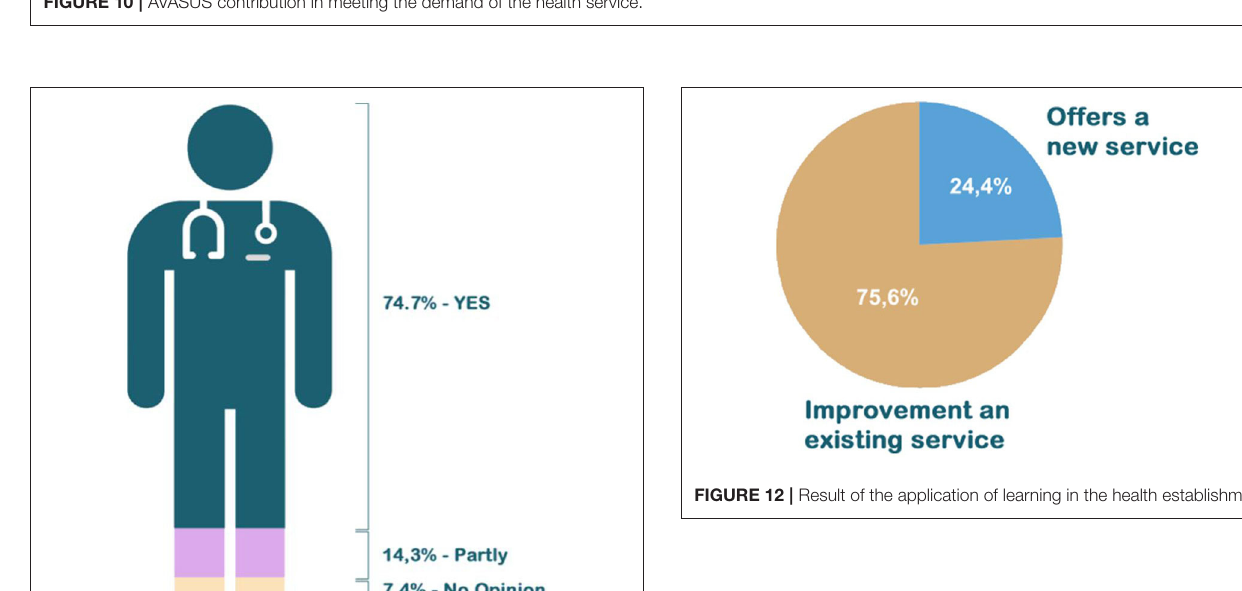
FIGURE 10 | AVASUS contribution in meeting the demand of the health service.